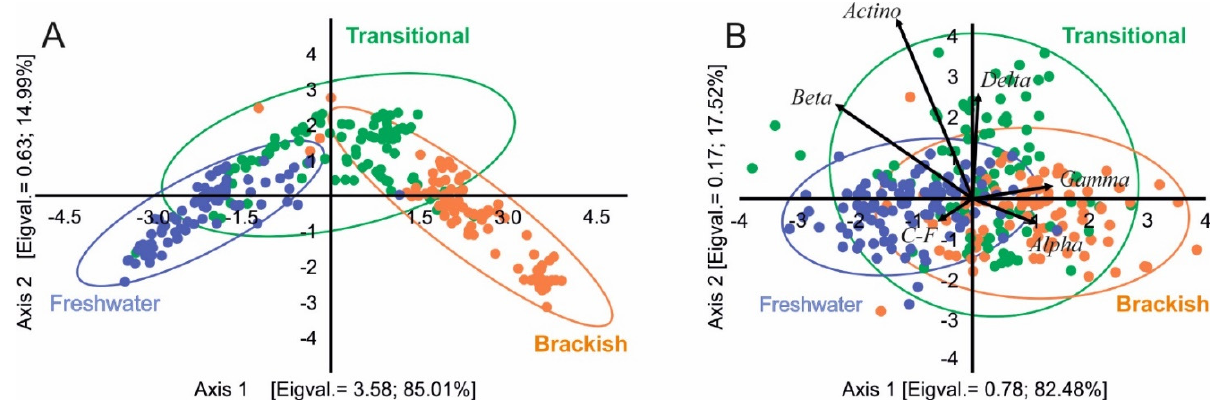
Figure 2. Principal coordinates analysis (PCoA) for physico-chemical parameters of water ( A ) and microbiological data ( B ).